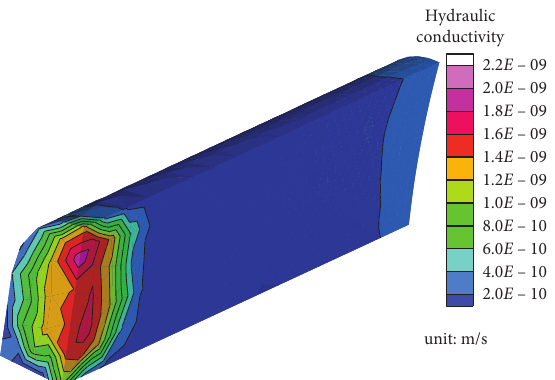
Figure 9: The hydraulic conductivity distribution map when thr reduction factor F i � 1.10.